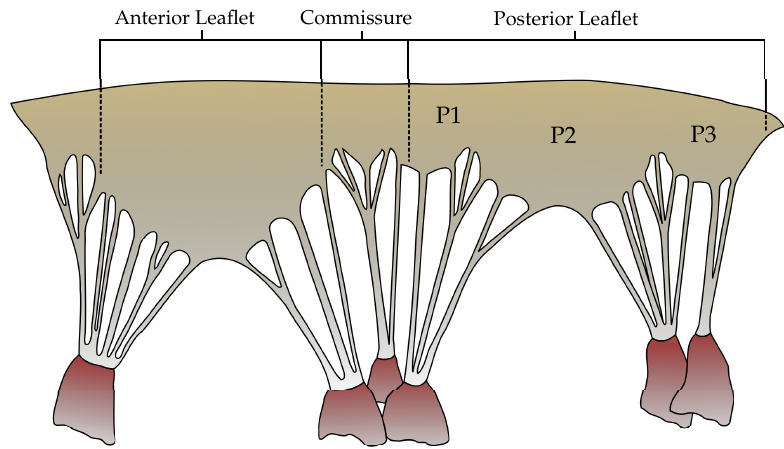
Figure 1. The geometry of unfolded MV; the papillary muscles attach via chordae tendineae to the anterior, posterior and commissural leaflets